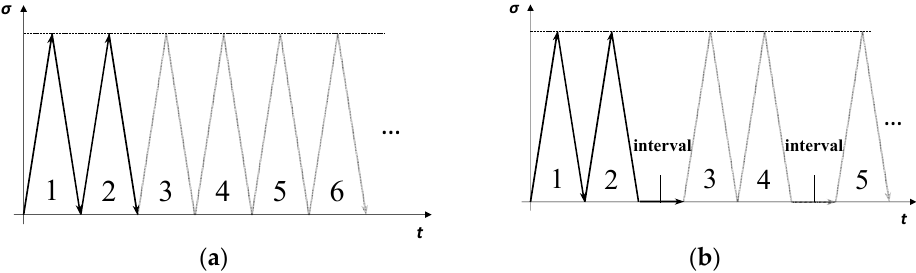
Figure 4. Stress paths of ( a ) classic fatigue and ( b ) fatigue as a function of time interval.